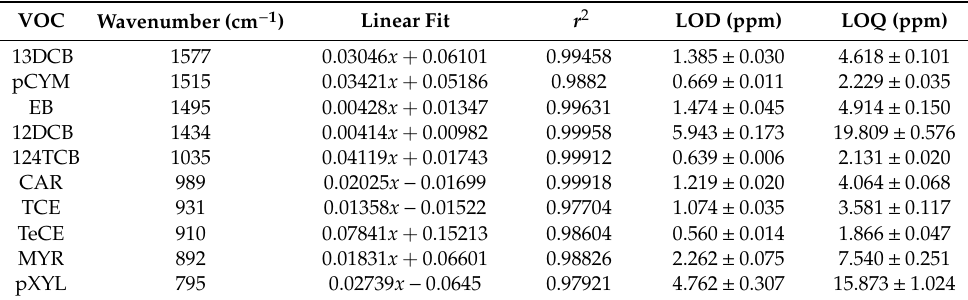
Figure 5. Exemplary diffusion curve of TeCE at a concentration of 10 ppm in an E/P-co polymer layer at 910 cm −1 . The enrichment process was fitted with a limited growth function.